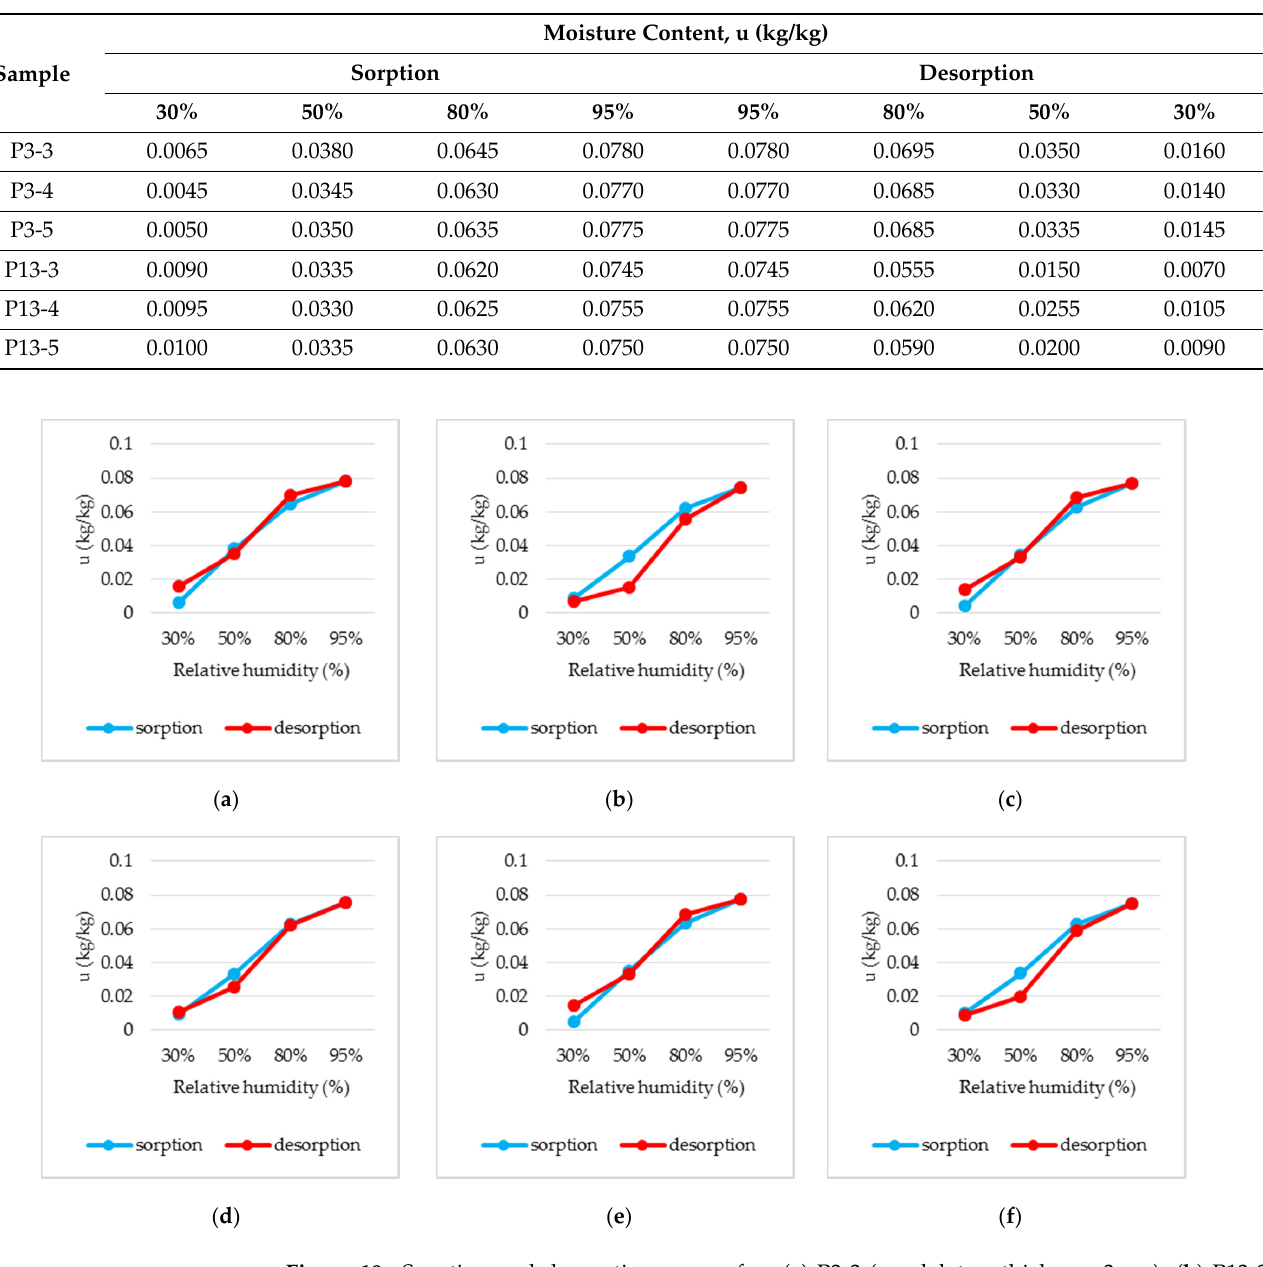
Table 4. Moisture content values of samples for relative humidity of 30, 50, 80 and 95%.